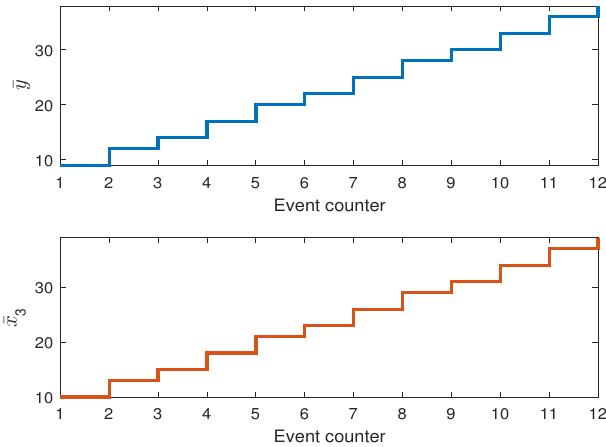
Figure 15. Scenario 1: Optimal sequence ¯ y ( k ) for AGVs.